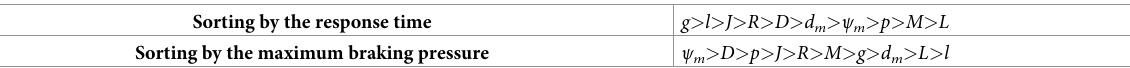
Table 7. Parameters sensitivity sorting. Sorting by the response